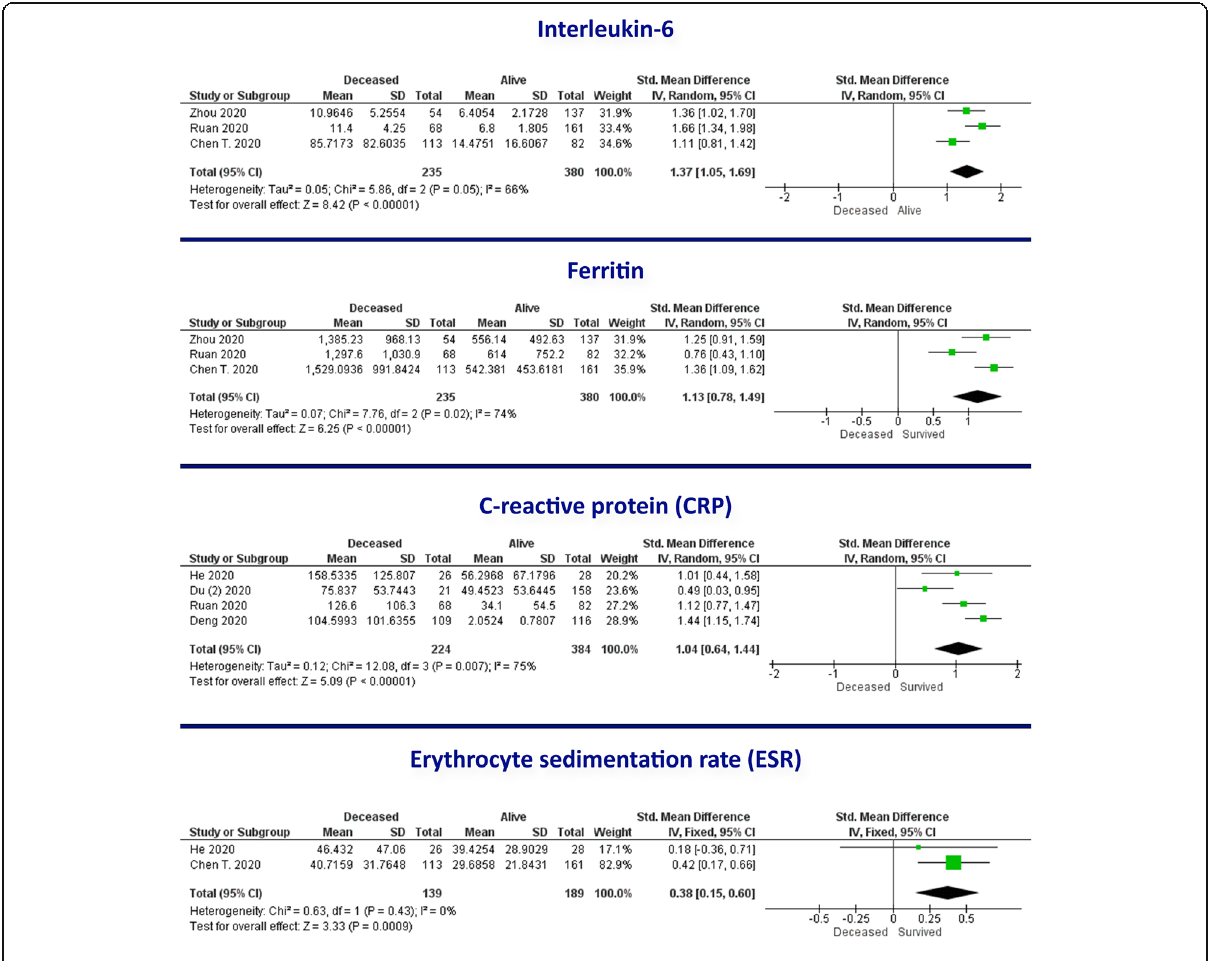
Fig. 6 Forest plots showing the standardized mean difference of interleukin-6, ferritin, CRP and ESR between the deceased and survived